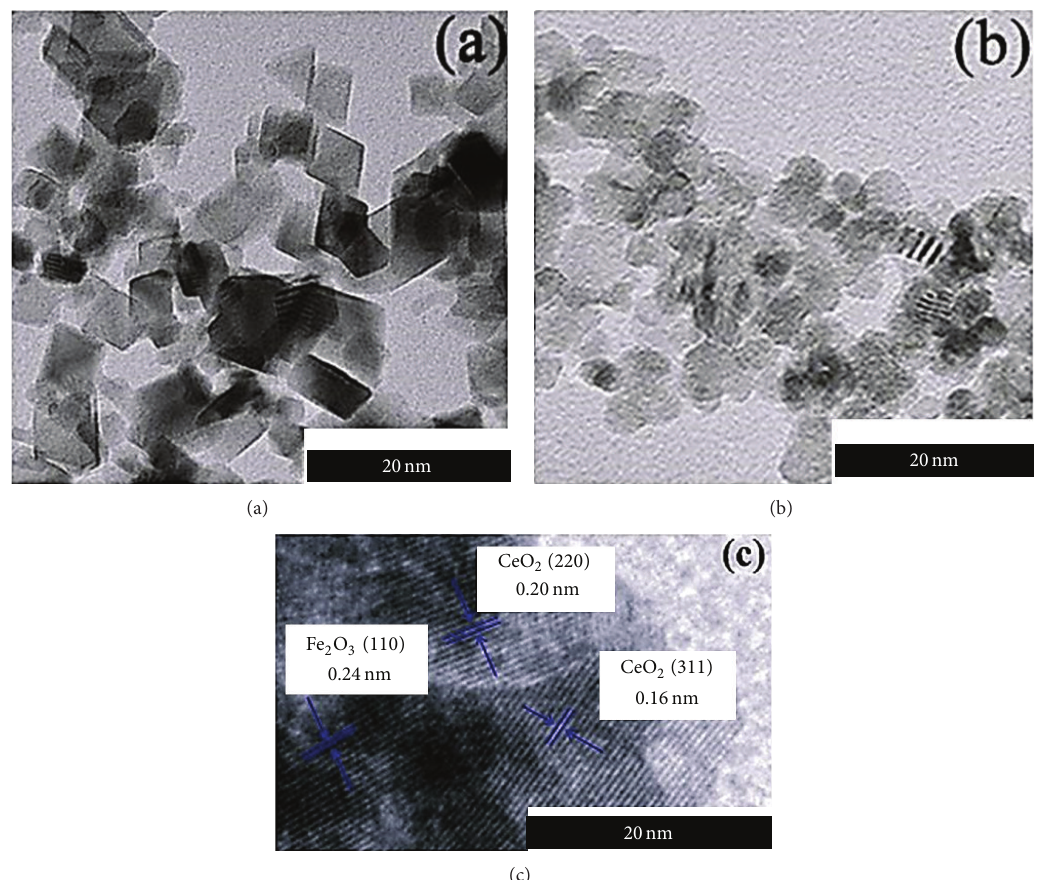
Figure 3: HRTEM images of (a) unloaded CeO 2 , (b) 2.00 mol% Fe-loaded CeO 2 , and (c) lattice fringe of 2.00 mol% Fe-loaded CeO 2 .